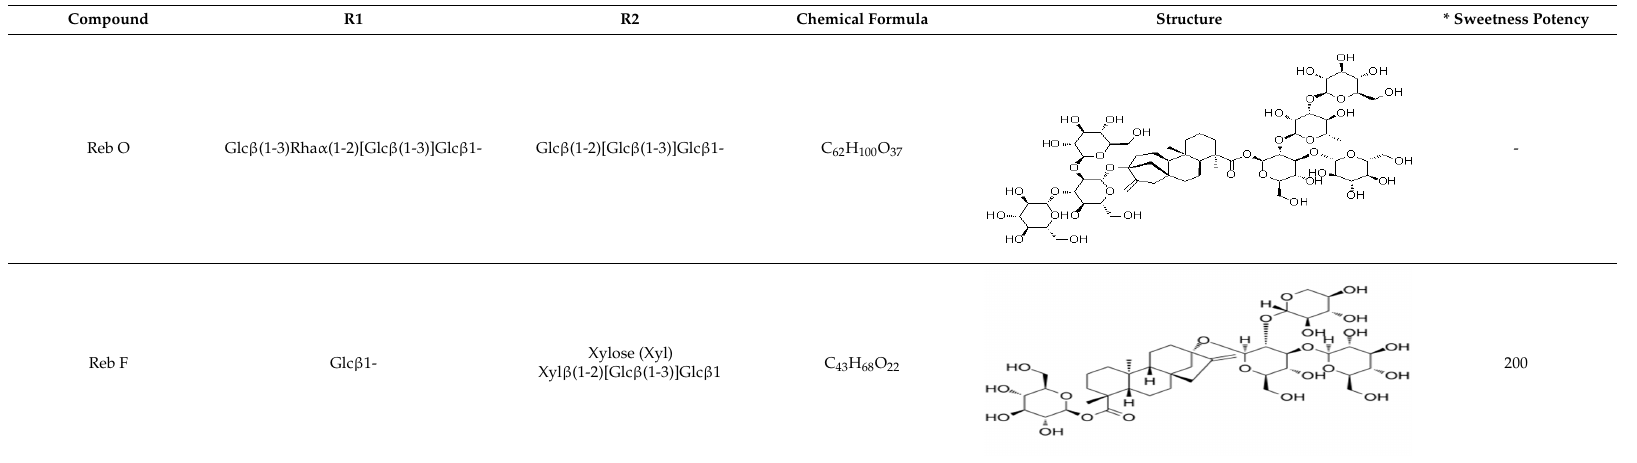
* Sweetness potency-the indicated estimate values are times that of sucrose.